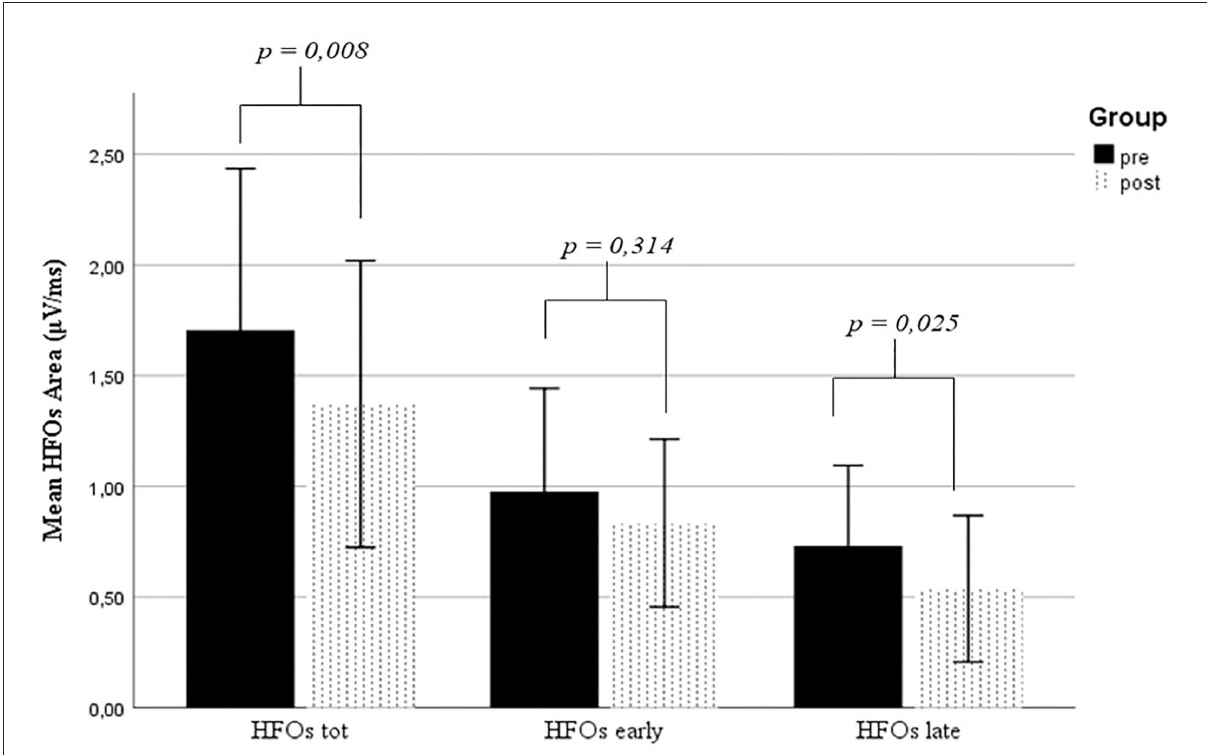
FIGURE1 Comparison of HFO values between T0 and T1. HFOs, high-frequency